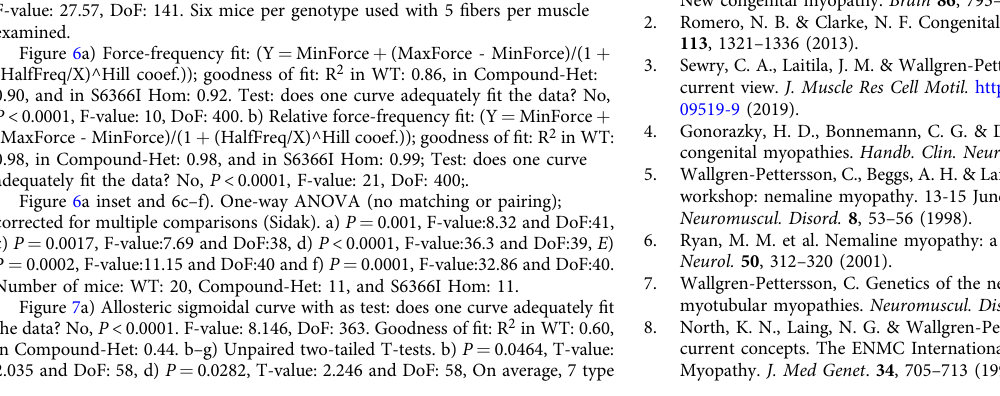
Figure 6a) Force-frequency fi t: (Y = MinForce + (MaxForce - MinForce)/(1 + (HalfFreq/X)^Hill cooef.)); goodness of fi t: R 2 in WT: 0.86, in Compound-Het: